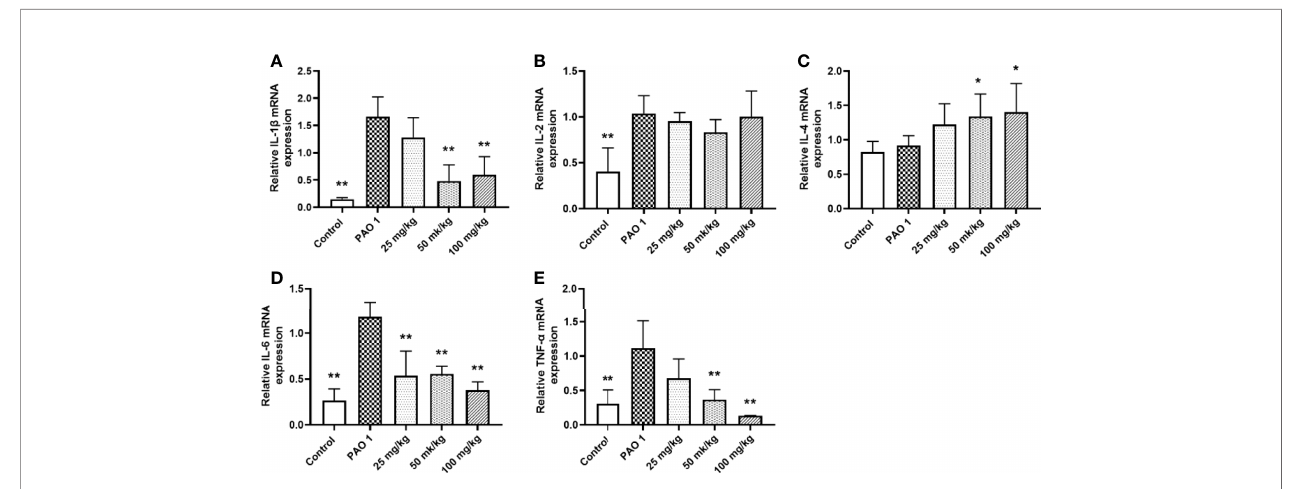
FIGURE 12 | Paeonol inhibited the mRNA expression of in fl ammation cytokines in the lung. All data were expressed as means ± SD (n=3). (A) IL-1 b , (B) IL-2, (C) IL-4, (D) IL-6, (E) TNF- a . * P < 0.05 or ** P < 0.01 vs PAO1